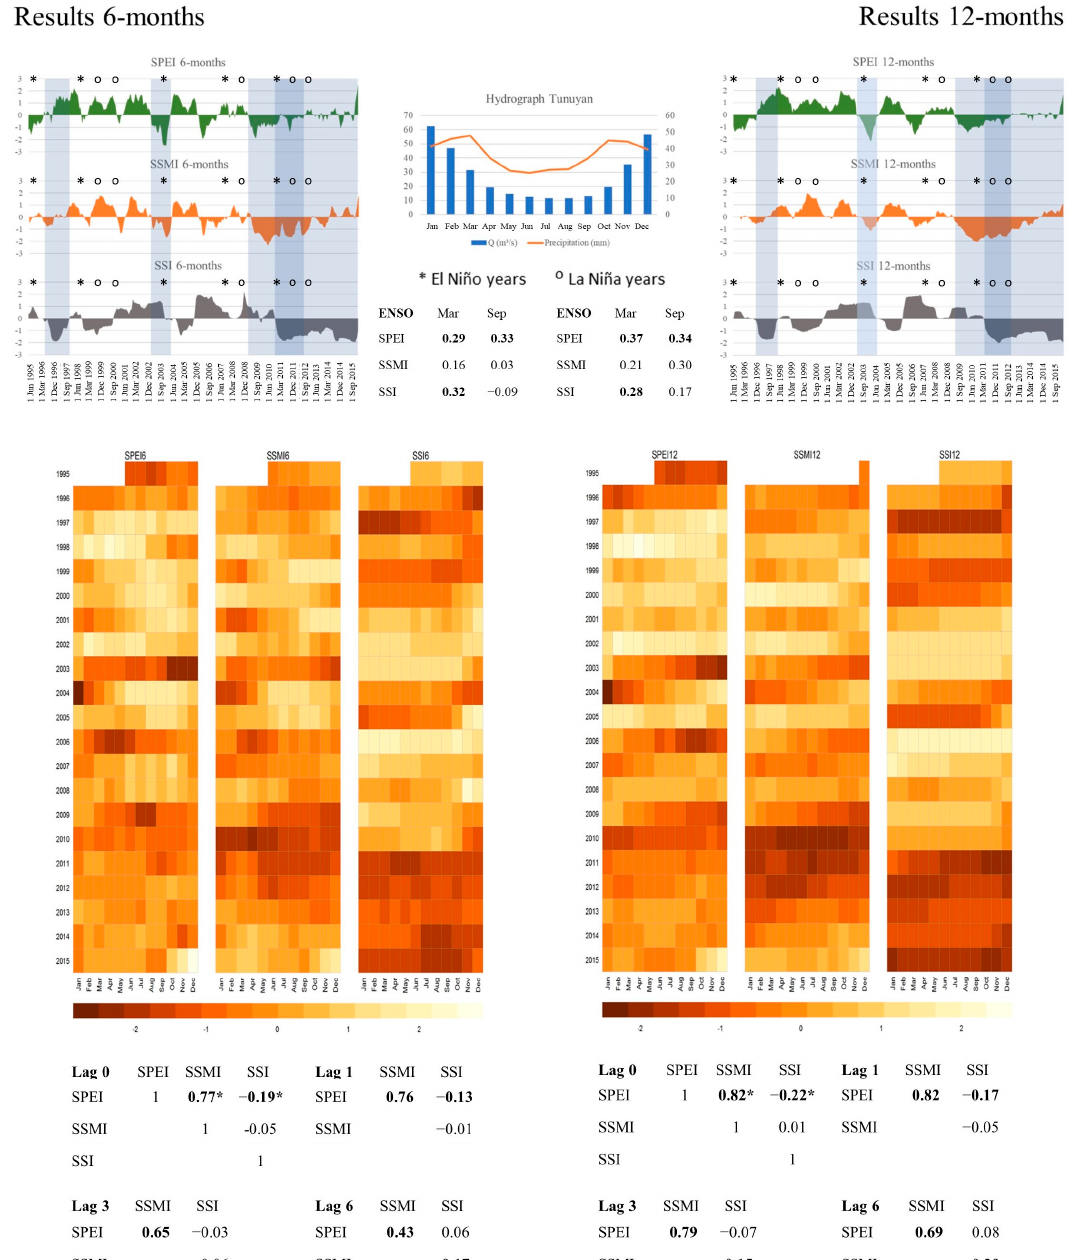
Figure 7. Graphical summary of results for the Tunuyán river basin.